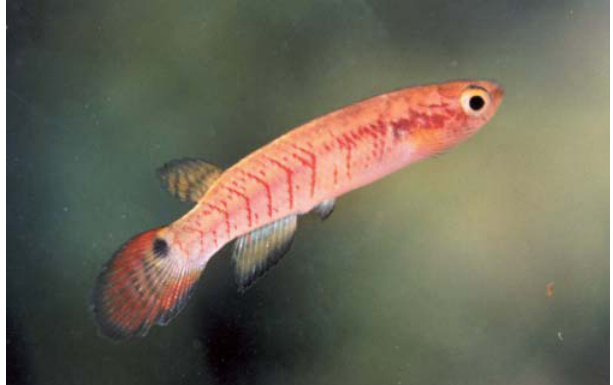
Table 5. Morphometric data of the holotype (H, UFRJ 5965, male) and paratypes (UFRJ 5966) of Rivulus rutilicaudus .